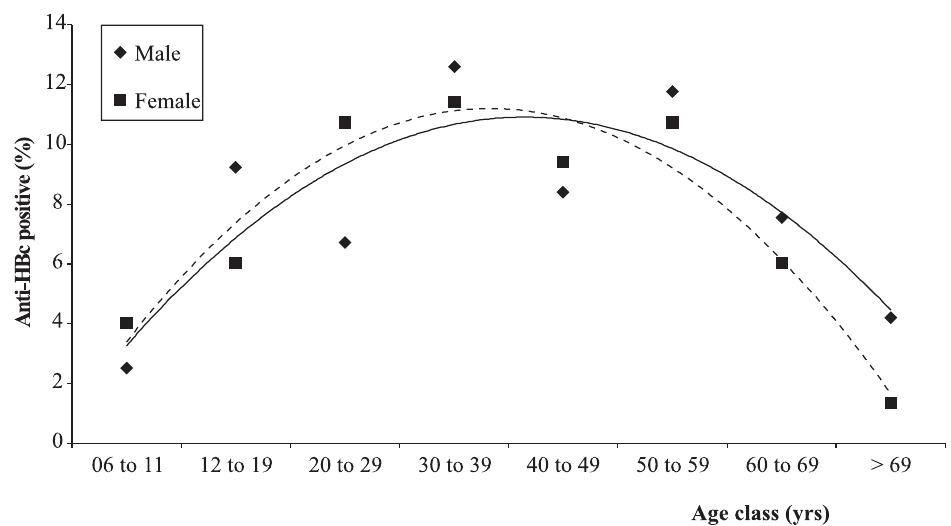
Figure 3 - Prevalence of Hepatitis B virus (HBV), as indicated by anti-HBc antibodies, stratified by gender and age with their